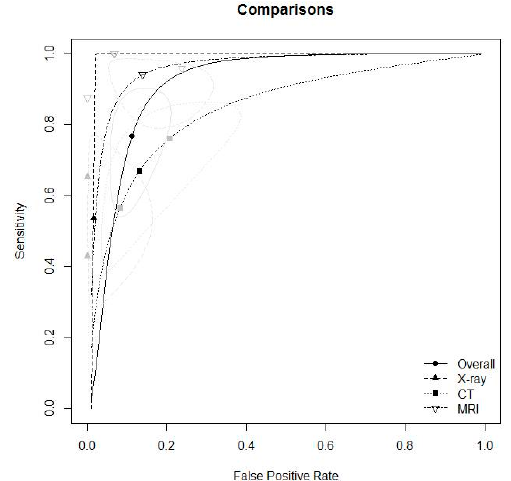
Figure 3. Comparison results for each diagnostic method.